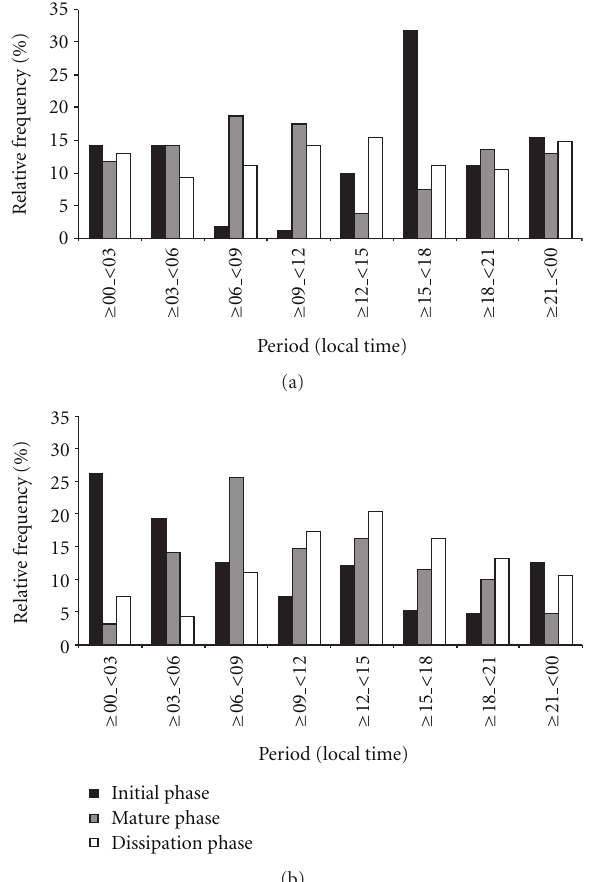
Figure 5: Average diurnal cycles of convective systems observed during 2003, over: (a) Continent; (b)